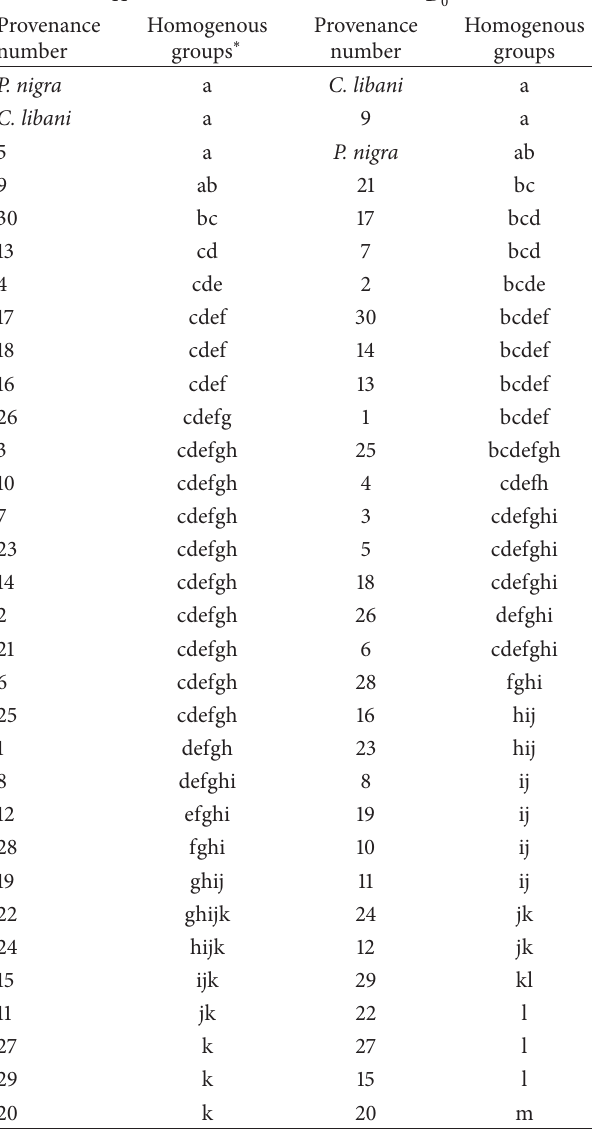
Table 4: Homogenous groups of Duncan’s multiple range tests. H D